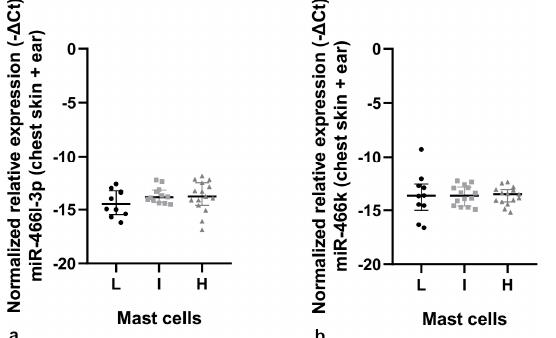
Figure 5. MiR-466l-3p and MiR-466k relative expression in K14-HPV16 transgenic mice. ( a ) MiR-466l-3p relative expression in chest skin and ear tissue together. ( b ) MiR-466k relative expression in chest skin and ear tissue together. L: low mast cell count; I: intermediate mast cell count; H: high mast cell count.